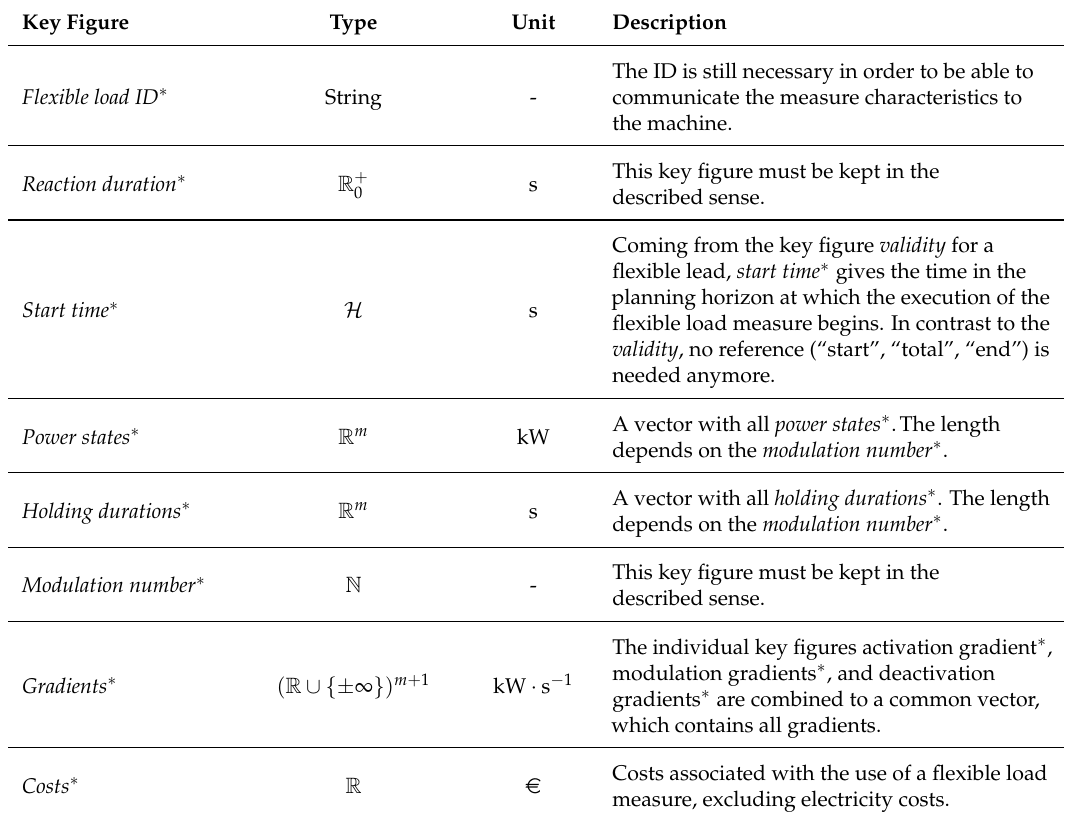
Table 4. Key figures for flexible load